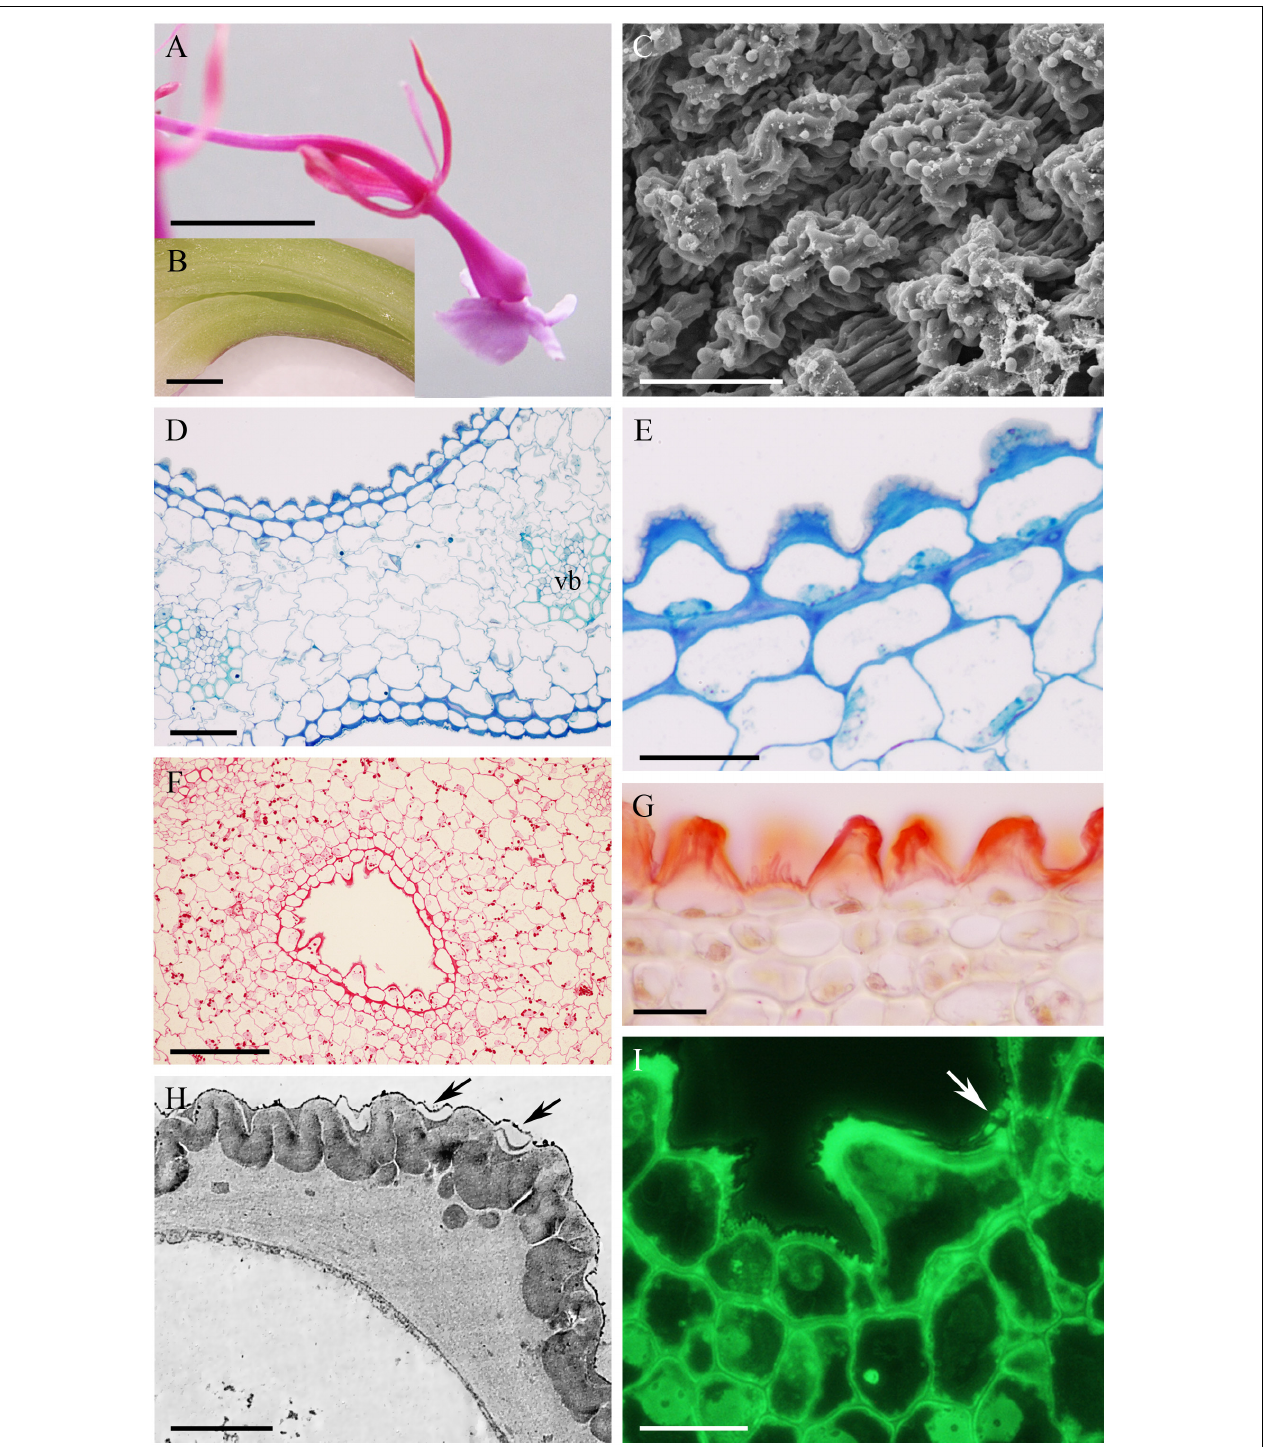
FIGURE 6 | Epidendrum capricornu . (A) Habit of the flower. (B) Longitudinal section showing cuniculus. (C) Globular blisters on epidermal cells lining cuniculus. (D) Conical cells of epidermis enclosing cuniculus and parenchyma with vascular bundles (MB/AII). (E) Detail showing epidermis and subepidermal parenchyma. Note the thick, tangential walls of the epidermal cells and the convoluted cuticle. (F) PAS reaction stains copious starch present in papillose epidermis and subepidermal parenchyma. (G) Cuticle stained with Sudan III. (H) Outer epidermal cell wall with globular electron-dense material between cellulosic microfibrils, and blistered cuticle (arrows). (I) Section showing conical, epidermal cells and subepidermal parenchyma. Globules of secretion indicated by arrow. Scale bars: A = 1 cm; B = 1 mm; C,E,G,I = 20 µ m; D = 50 µ m; F = 200 µ m; H = 2 µ m.